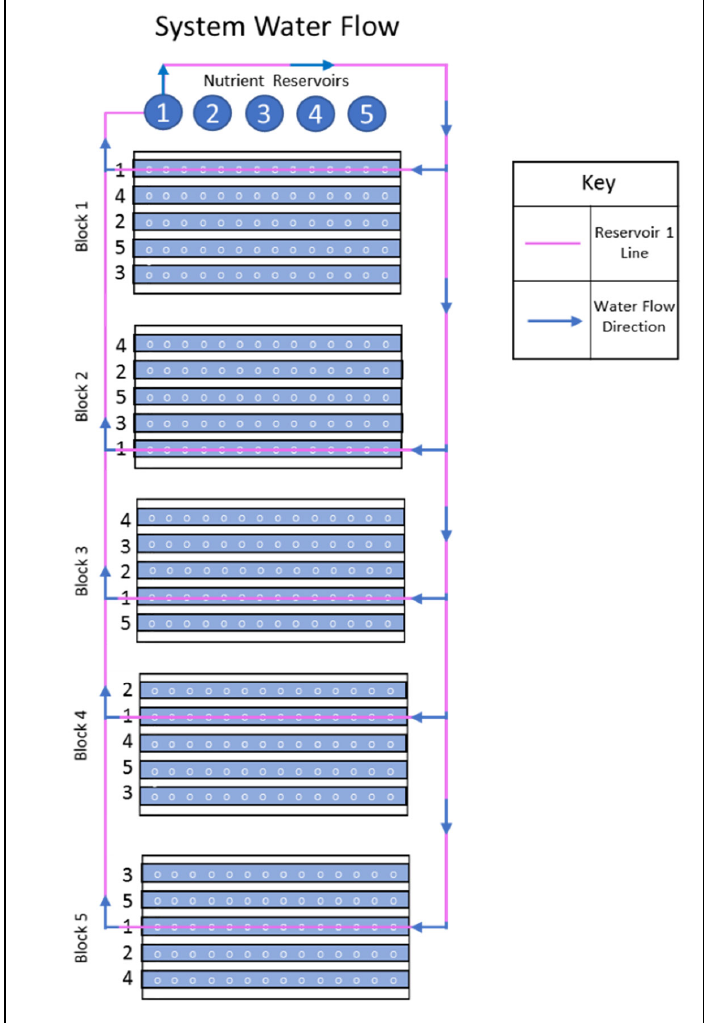
Figure 2. NFT System Water Flow .